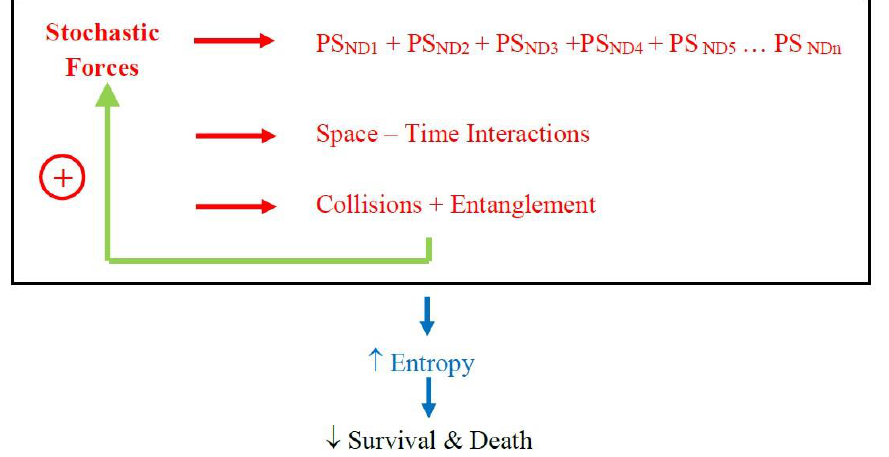
Figure 4. Stochastic mechanisms determine neurodegenerative protein sequences that interact in space-time, collide and become entangled with other proteins and structures  entropy increases space-time, collide and become entangled with other proteins and structures → entropy increases and neurodegeneration ensues. and neurodegeneration